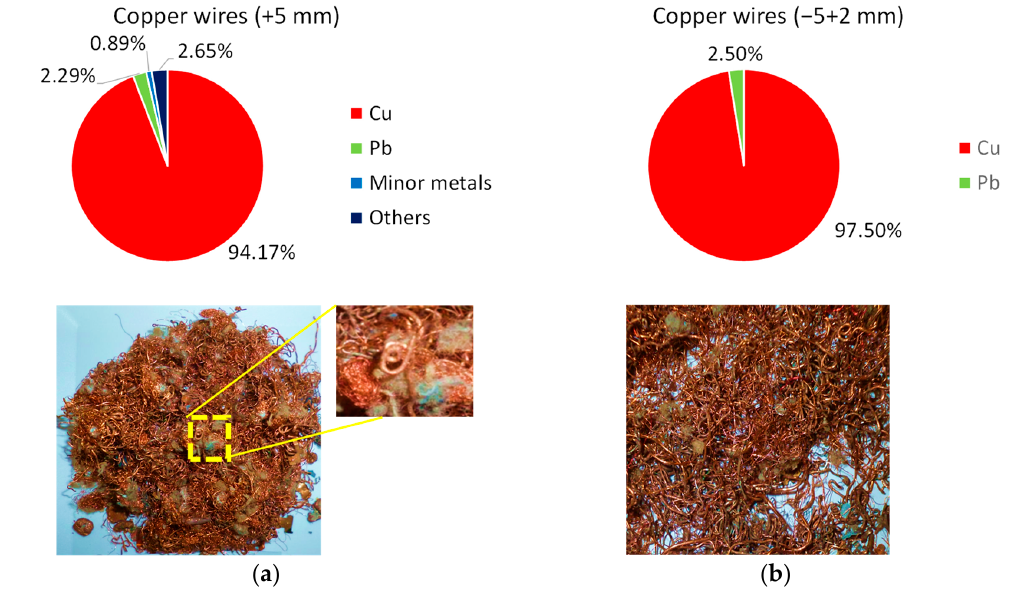
Figure 7. Elemental composition and pictures of copper wires separated in the +2.8 g/cm³ fraction. ( a ) + 5 mm; ( b ) − 5 + 2 mm. “Minor metals” consider the sum of the elements Cu, Al, Fe, Sn, Zn, Pb, Ba, Mn, and Ni when not individually displayed. “Others” consider the sum of non-metallic elements and trace metals.